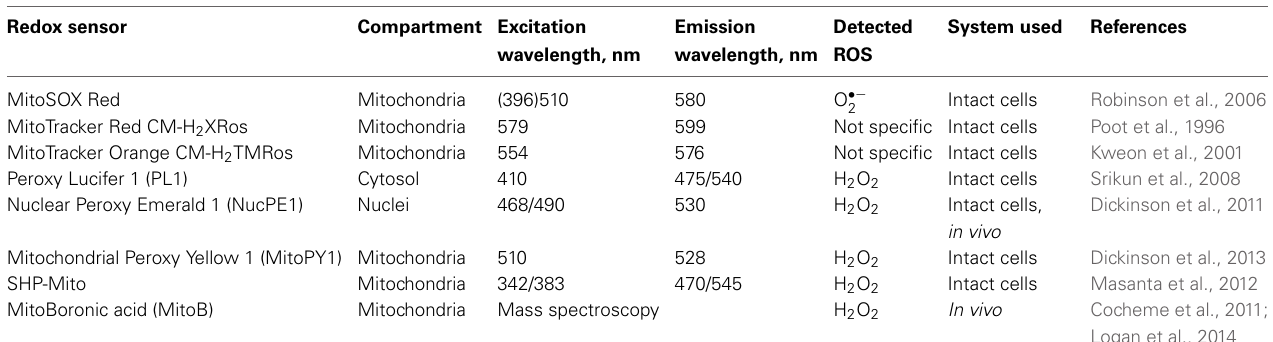
Table 1 | Small molecule fluorescent redox sensitive probes and their